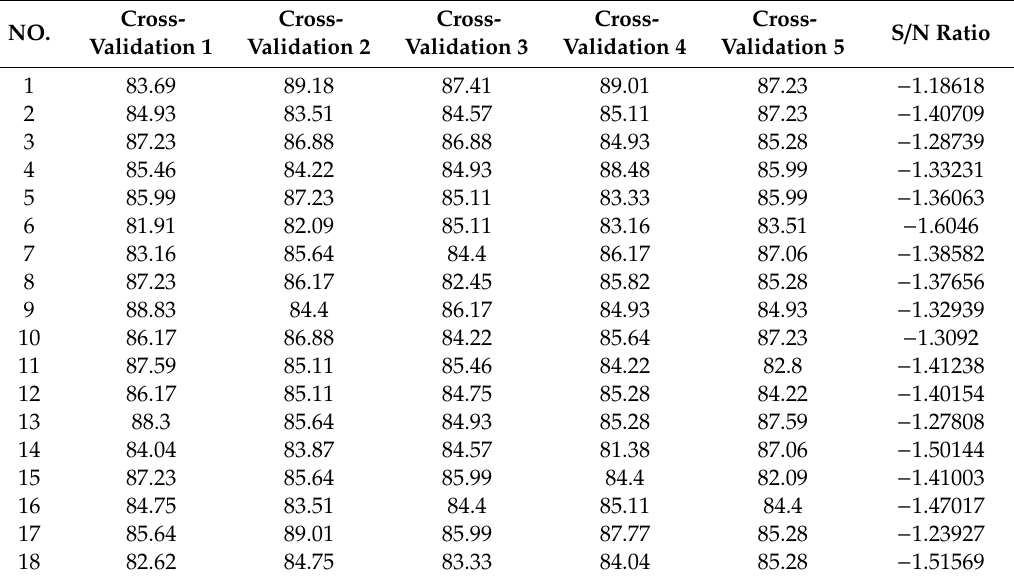
Table 5. Accuracy and S / N ratio of AlexNet in CIA data set.